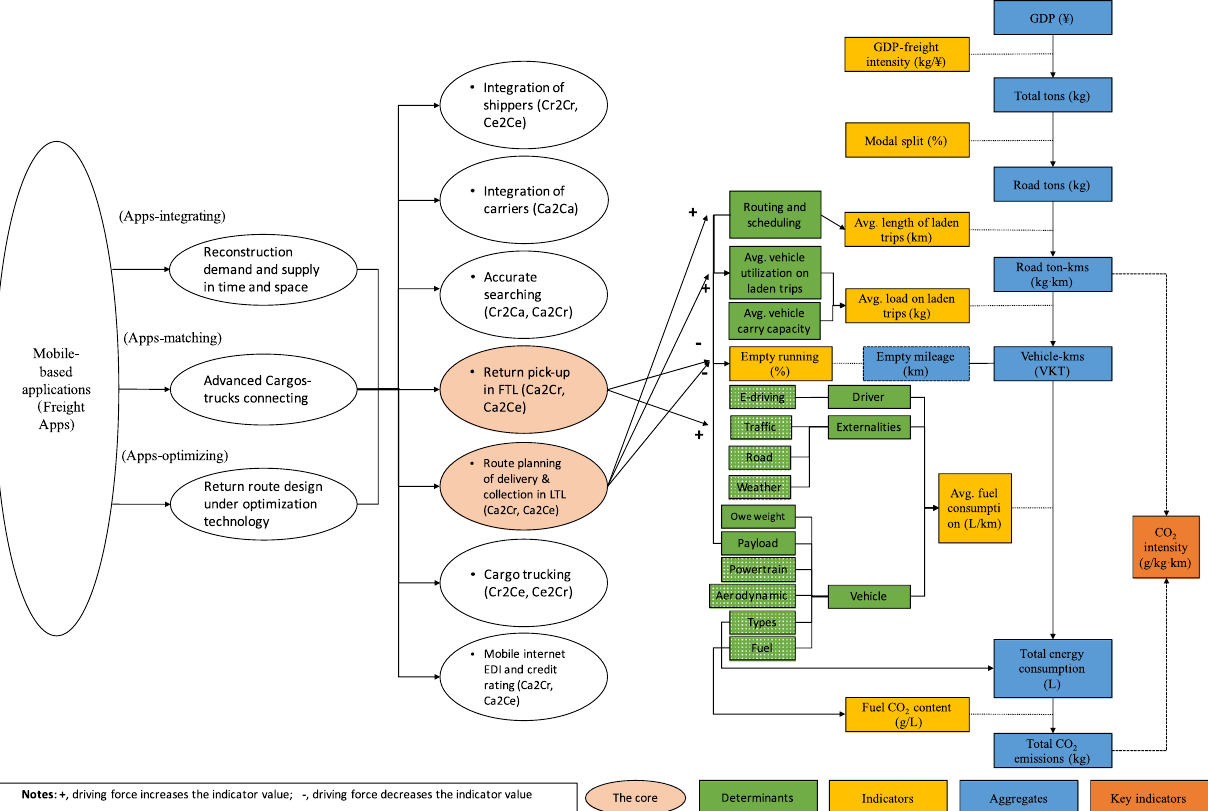
Fig. 5 Framework for analyzing freight apps for CO 2 reduction. Source: Modified from [43,